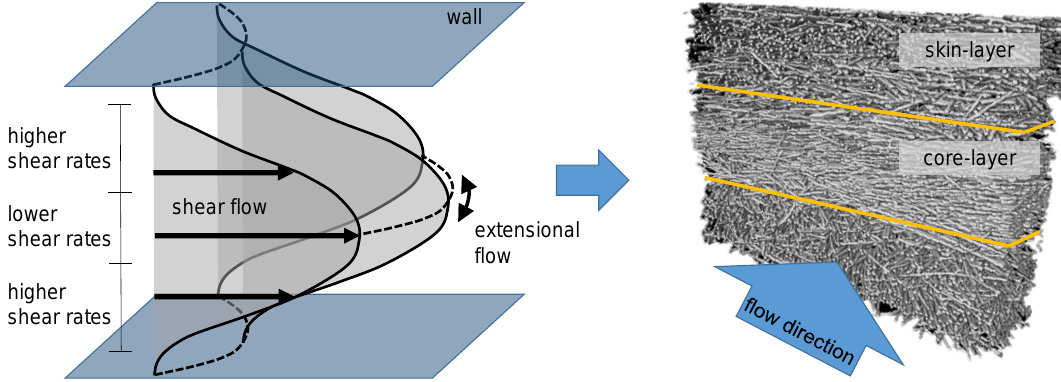
Figure 2. Velocity profile and the resulting fiber orientation distribution according to [51].